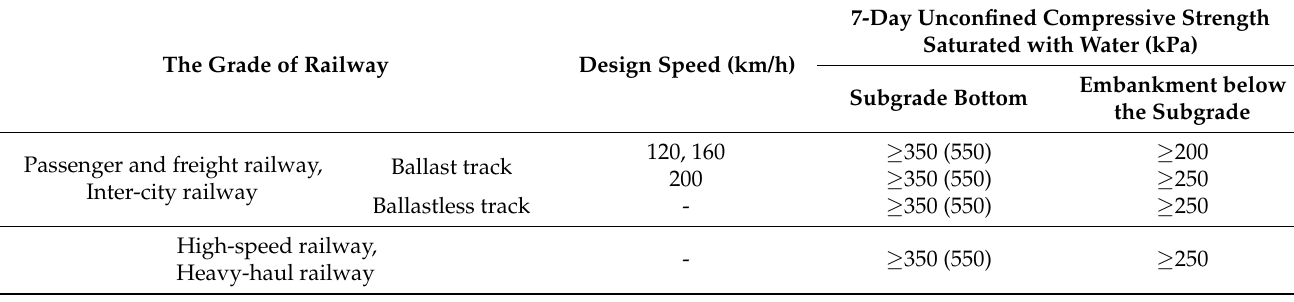
Table 1. The strength requirement of stabilized soil in